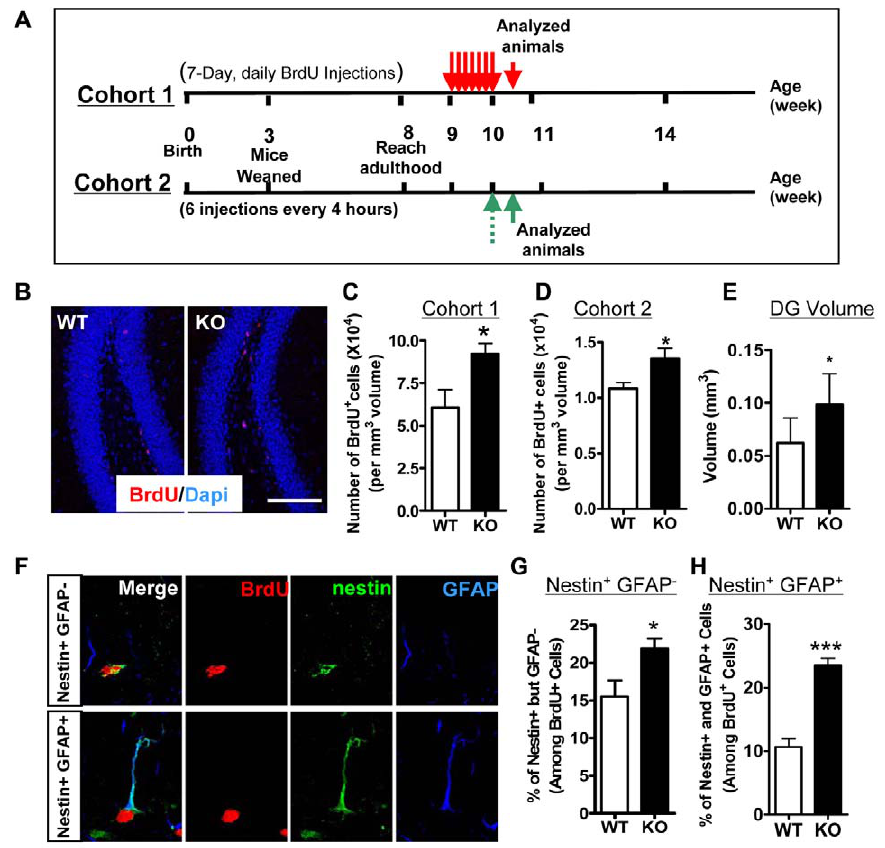
Figure 3. Loss of Fmrp alters the proliferation of neural stem and progenitor cells invivo . (A) Experimental scheme for assessing cell proliferation in the adult hippocampus. Cohort 1 animals had the same injection paradigm as Figure 4 and were therefore used to assess new cell survival. Cohort 2 animals were used to evaluate cell proliferation in the DG. (B) Examples of WT and Fmr1 KO brain sections stained with an antibody against BrdU (red) and DAPI (blue) for in vivo neurogenesis analyses (scale bar =100 m m). (C) The dentate gyrus (DG) of Fmr1 KO mice exhibited increased BrdU + cells analyzed at one day after a 7-day regimen of daily BrdU injections, suggesting increased proliferation (Cohort 1: n=3 WT; n=4 KO). (D) At 4 hours post-BrdU injection (6 injections within 24 hours), the number of BrdU + cells normalized to volume of the DG was also higher in Fmr1 KO mice (p , 0.05). (D–I, Cohort 2: n=7 WT; n= 6 KO). (E) Fmr1 KO mice also had increased DG volume (size) (p , 0.05). (F) Single intensity projection confocal z-series showing two different types of BrdU + cells in the DG of the hippocampus. Upper panel, BrdU + (red), Nestin + (green), and GFAP 2 (blue) progenitor cells; Lower panel, BrdU + (red), Nestin + (green), and GFAP + (blue) stem-like cells. (G) The DG of Fmr1 KO mice exhibited increased proliferation of progenitor (BrdU + Nestin + , GFAP 2 ) cells analyzed at 4 hours following 6 BrdU injections within a 24-hour period. (H) The DG of Fmr1 KO mice exhibited increased proliferation of stem (BrdU + Nestin + , GFAP + ) cells analyzed at 4 hours after 6 BrdU injections within a 24-hour period. (n=7 WT; n=6 KO). Data are presented as mean 6 SEM; *, p , 0.05, **, p , 0.01, ***, p , 0.01, Student’s t-test.